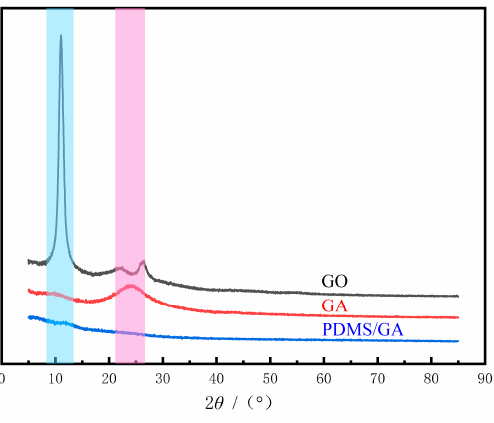
Figure 3. XRD of raw GO, GA and PDMS/GA (The blue shade indicates 2 θ = 10.990°; The purple shade indicates 2 θ = 24.014°).